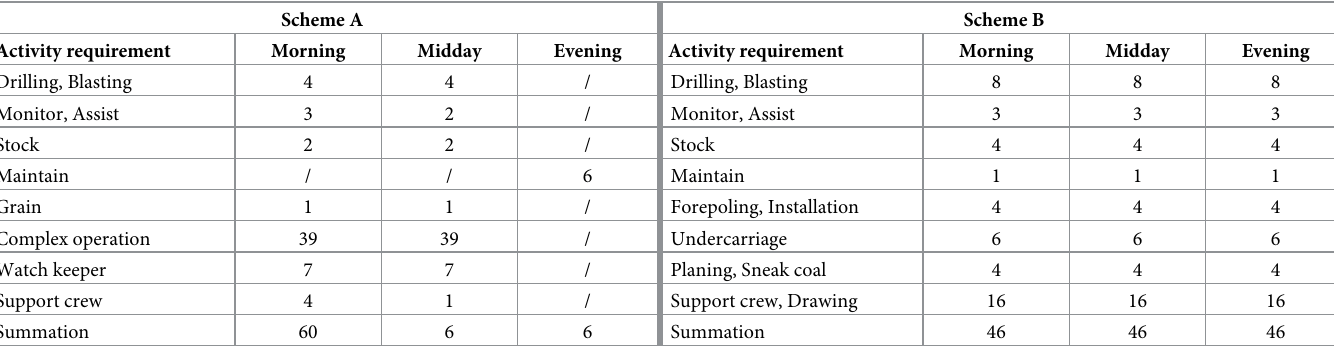
Table 5. Personnel organization and distribution in the working